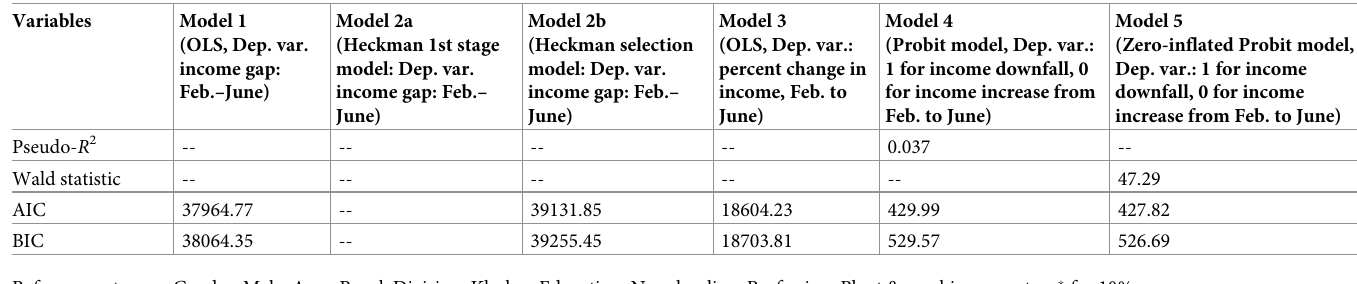
operators, workers involved with service and sales had on an average BDT 2,248 (US$ 26) higher income gap from February to June. As the agriculture sector was not completely shut down during the pandemic [10], only a few job sectors were affected significantly. Table 7 explained five different models for food expenditure downturn and according to AIC, BIC and significance of coefficients, Model 1 with OLS and Model 3 with percent changes showed a better fit. Heckman specification model delineated a similar pattern to the OLS model and the estimated rho was insignificant. The covariate age depicted an increasing pat- tern of food expenditure shortfall, but due to the nonlinear impact of age, the food expenditure gap reduced after a while. Female workers had a greater expenditure gap (BDT 135, US$ 2) in amount and percent change (3.33) compared to that of their male counterparts. Urban infor- mal workers faced a larger food expenditure downfall than that of the rural workers both in amount and in percentage (4.06%) with a high statistical significance. Workers from the Khulna division had significantly lower food expenditure declines than those of the other divi- sions. On an average, workers with above secondary level education had a higher food expen- diture gap of BDT 345 (US$ 4) compared to that of the no-schooling workers at 1% level of significance. Association between profession and food expenditure gap was statistically insig- nificant. Overall the covariates outlined a similar kind of association and significance levels for both income and food expenditure downfall. Fig 5 exhibited the coefficient graphs of Model 1 differentiating the rural-urban confidence intervals. In the equation of income gap, informal workers in Mymensingh and Sylhet showed a high interval for the urban areas. In comparison, food expenditure dwindled in Dhaka and Mymensingh with a large confidence interval for the rural areas. As Model 1 in Tables 6 and 7 did not include the confidence intervals, only depicted the coefficients, standard errors, and significance, Fig 4 thus explained the interval changes